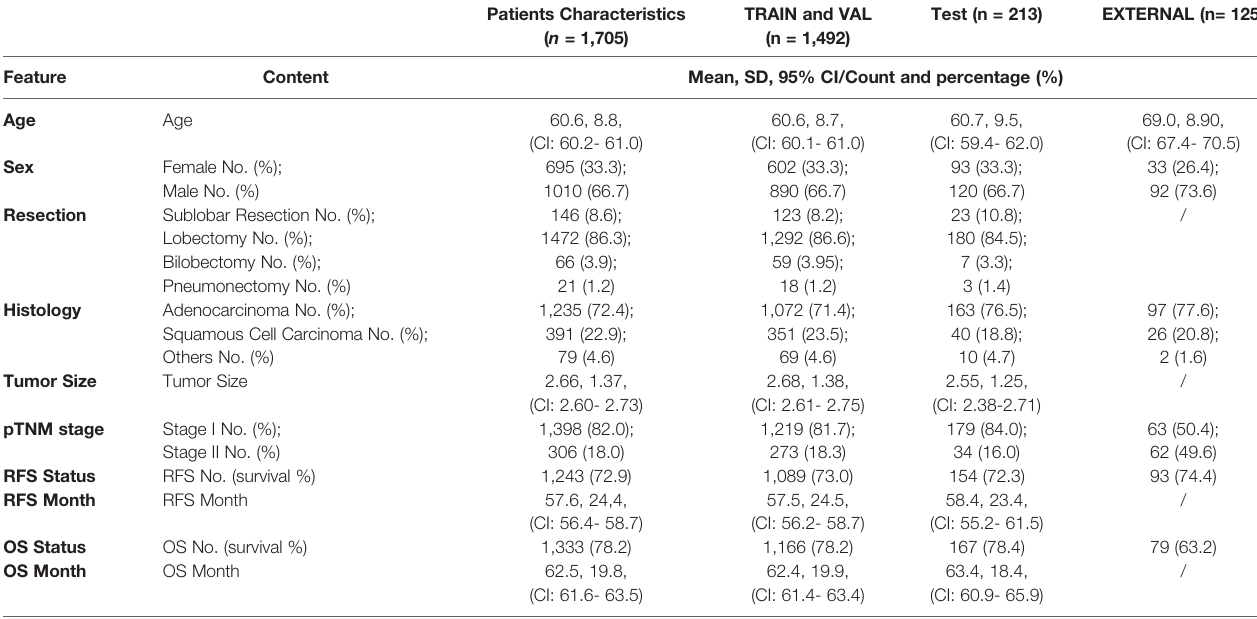
TABLE 1 | Feature distribution in the total patient cohorts, training and validation cohorts, and the test cohorts.